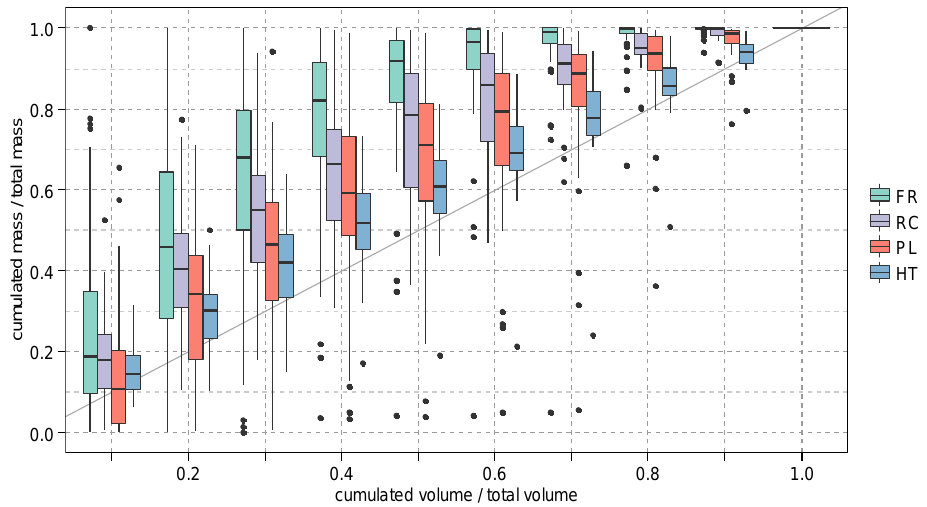
Figure 3. Site ‐ specific boxplots of M ( V ) ‐ curve distributions at runoff volume quantiles (FR: flat roof, RC: residential catchment, PL: parking lot, HT: high ‐ traffic street). Box ranges correspond to the first and third quartiles. Median is indicated by a solid black horizontal line. Whiskers comprise lowest/highest value within 1.5 × inter ‐ quartile range. Outliers exceed whiskers’ ends and are indicated by solid black dots.